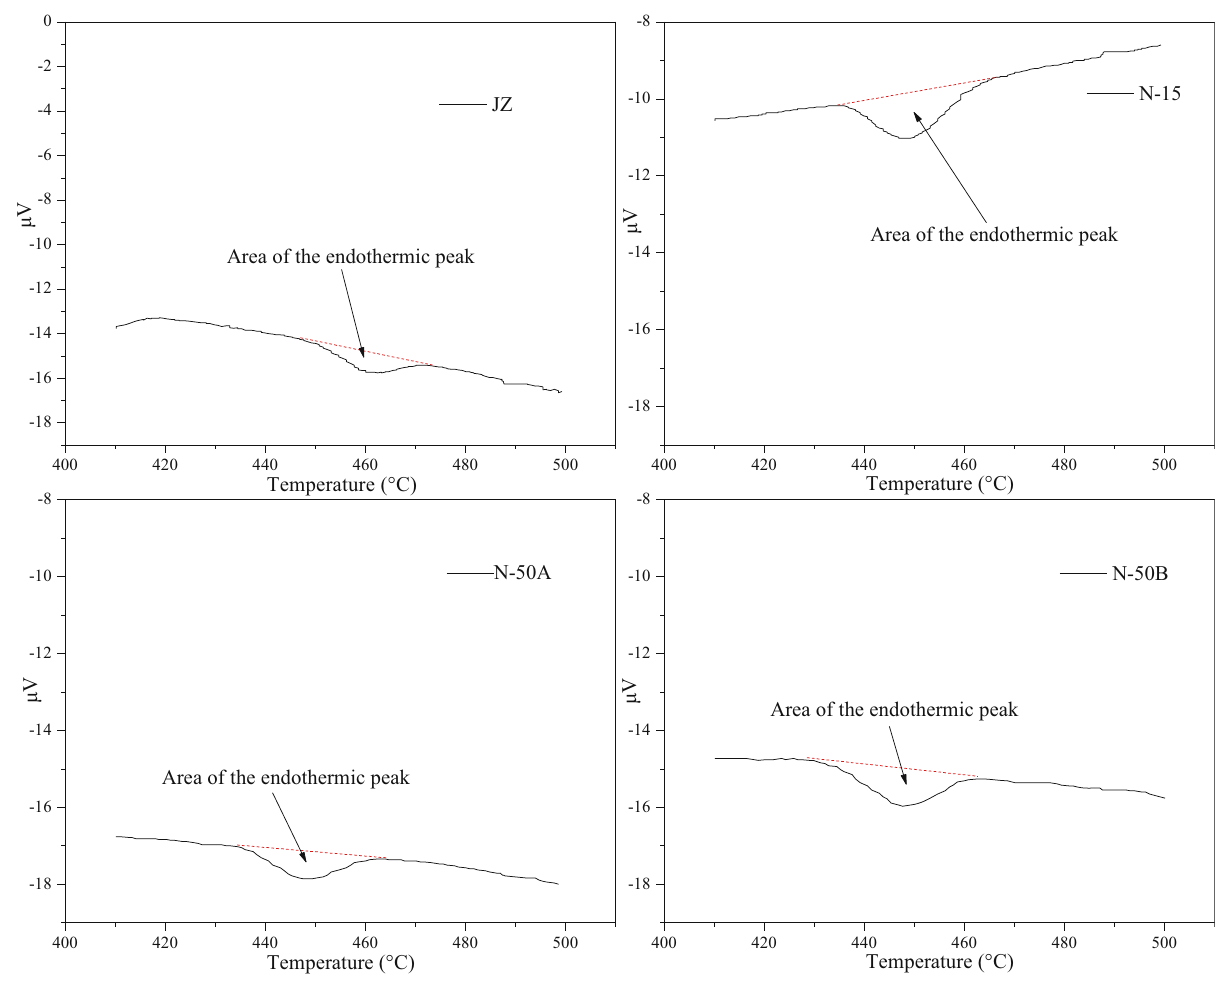
Figure 6: DTA curves of specimens at 1